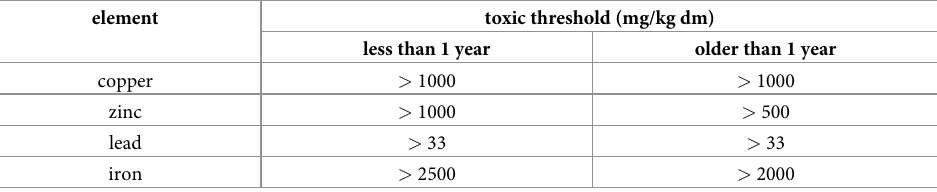
Table 2. Toxicologically relevant levels of elements in calf or cow livers (mg/kg dm).